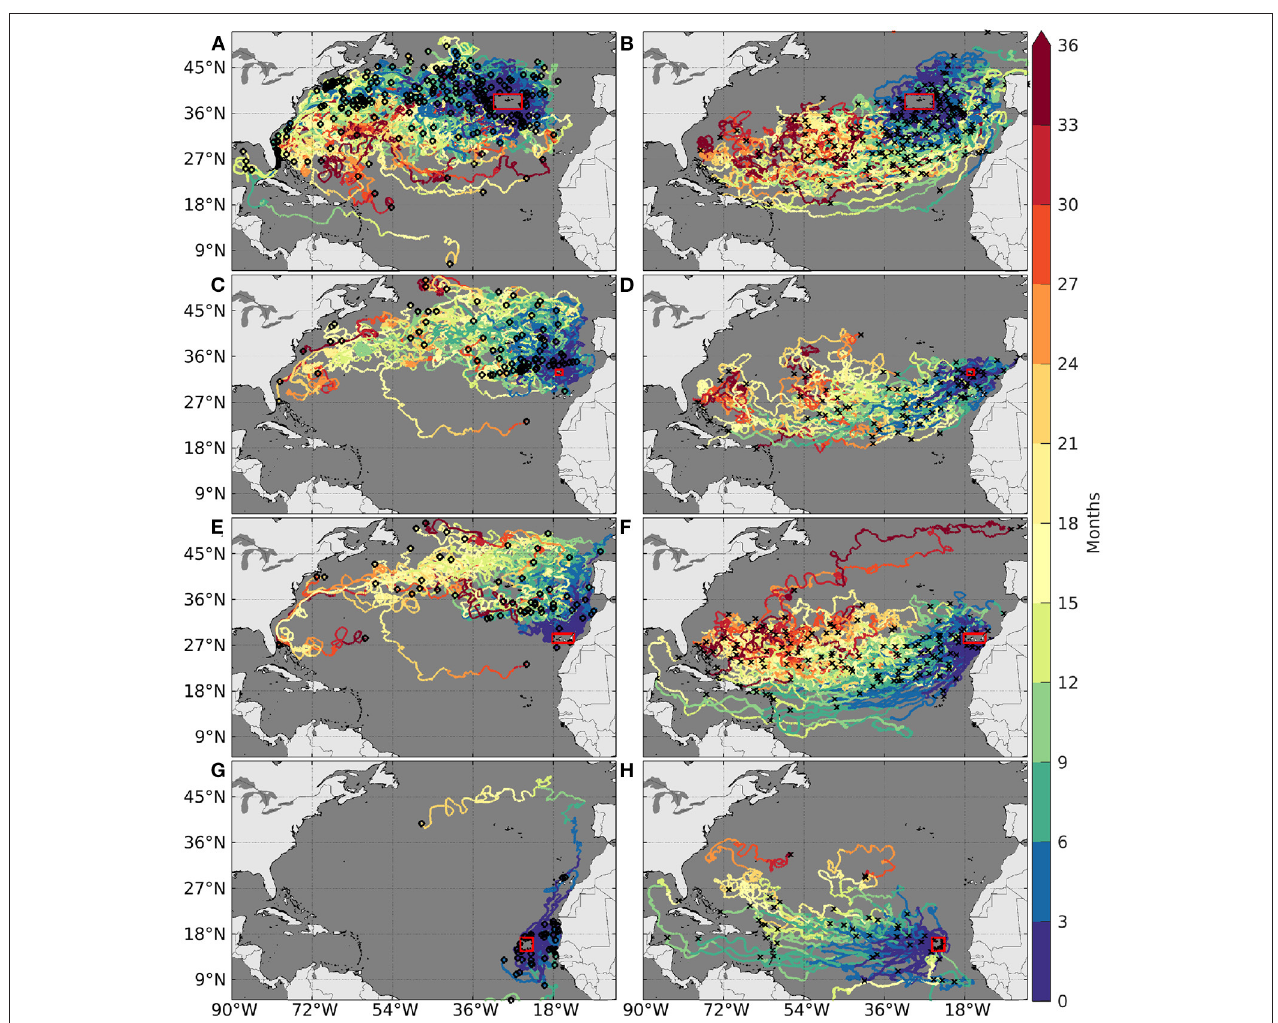
FIGURE 3 | GDP drifter trajectories and age (in months) before (left panels) and after (right panels) intersecting the Azores (A,B) , Madeira (C,D) , Canaries (E,F) , and Cabo Verde (G,H) . Red polygons around the archipelagos represent the delimited areas. Black circles and crosses mark the first and last transmitted position,